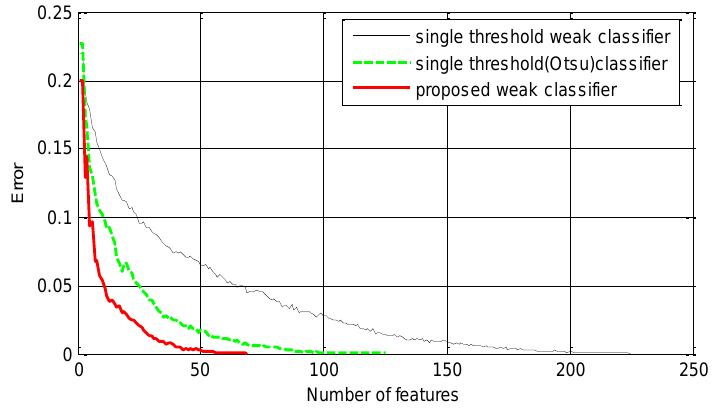
Figure 8. Plot of training error and the number of weak classifiers: the proposed weak classifiers and the single threshold (derived from average of means and Otsu’s optimal thresholding method) based weak classifiers.